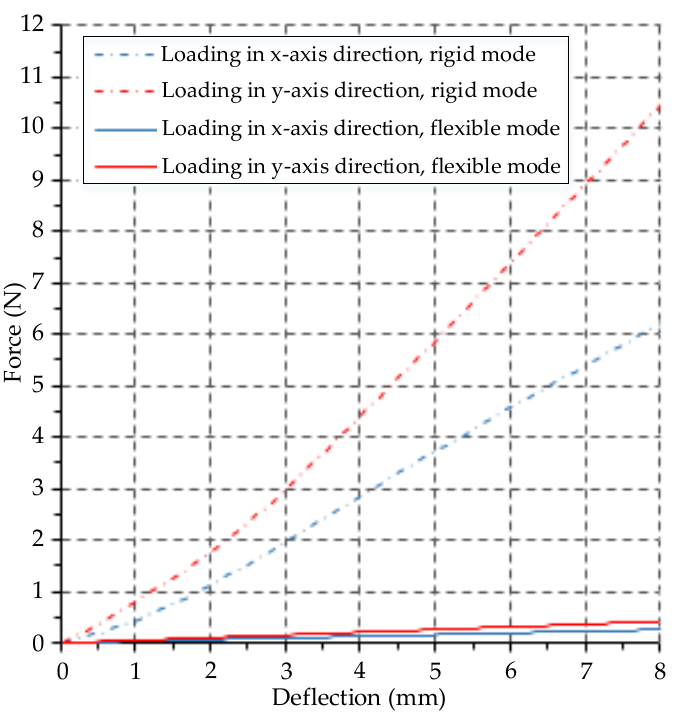
Figure 8. Bending stiffness test results for the designed variable stiffness endoscopic